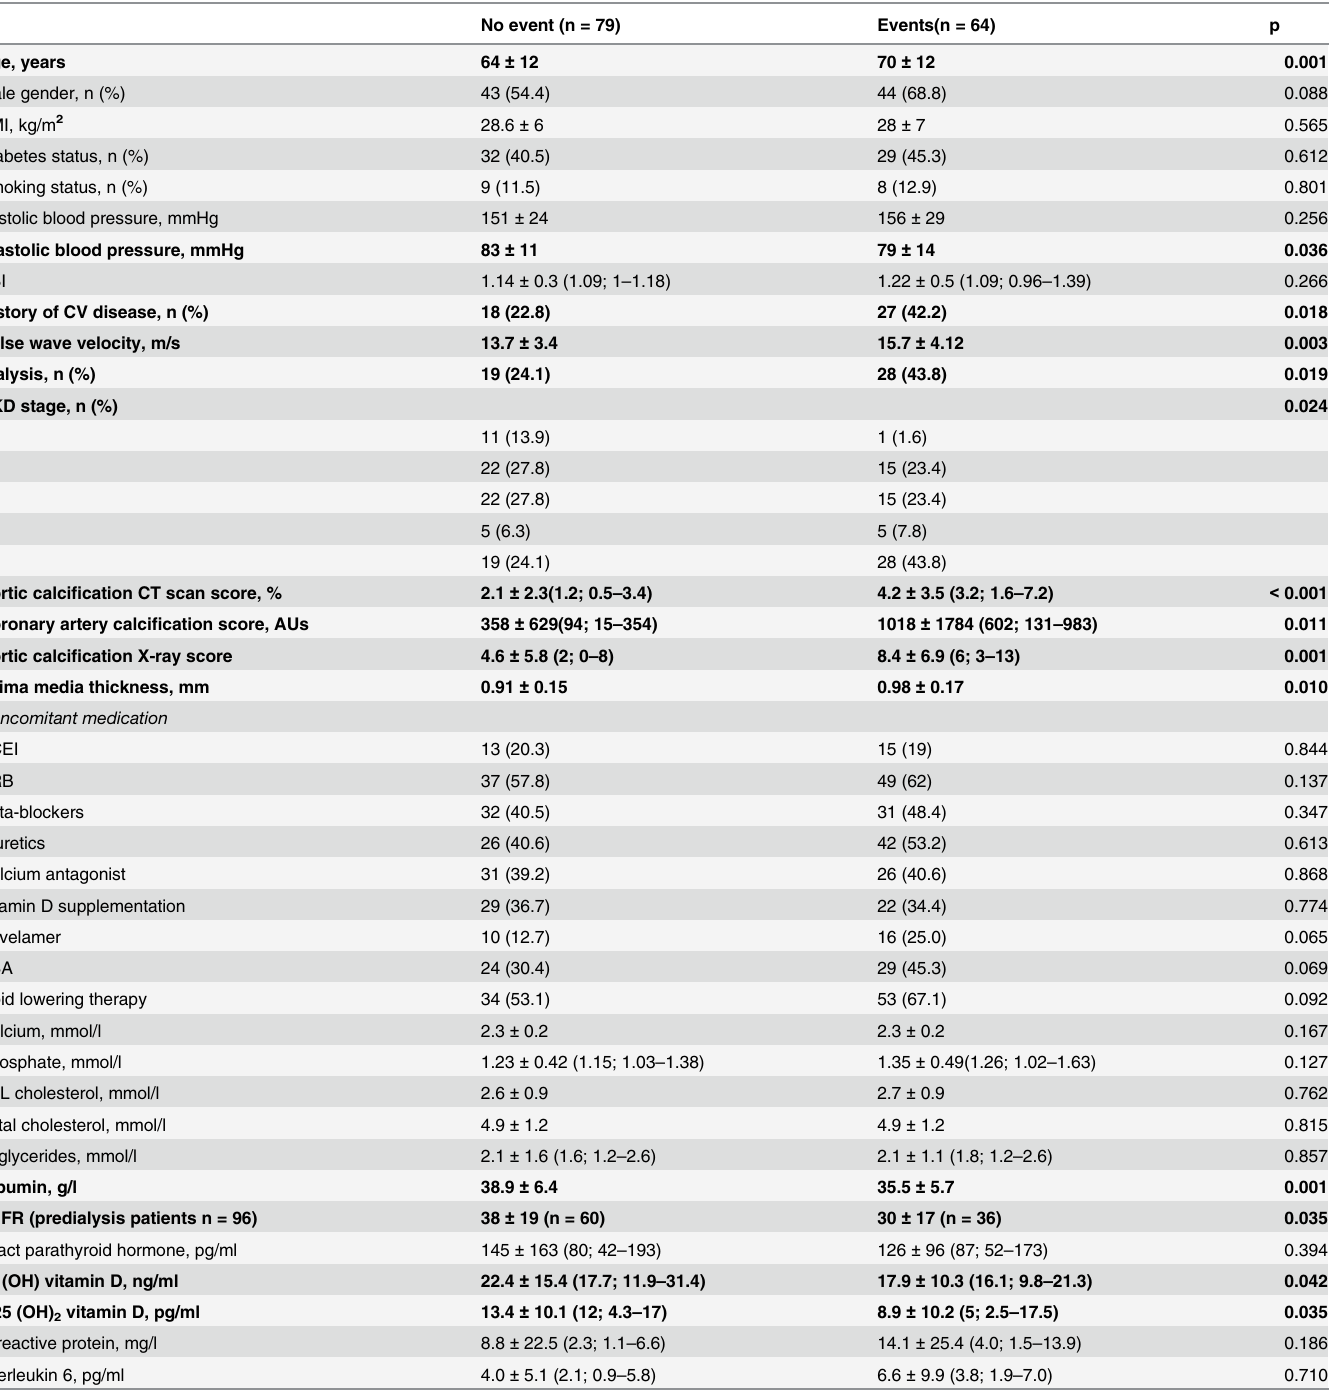
Table 1. Main demographic, biochemical and clinical characteristics, as a function of